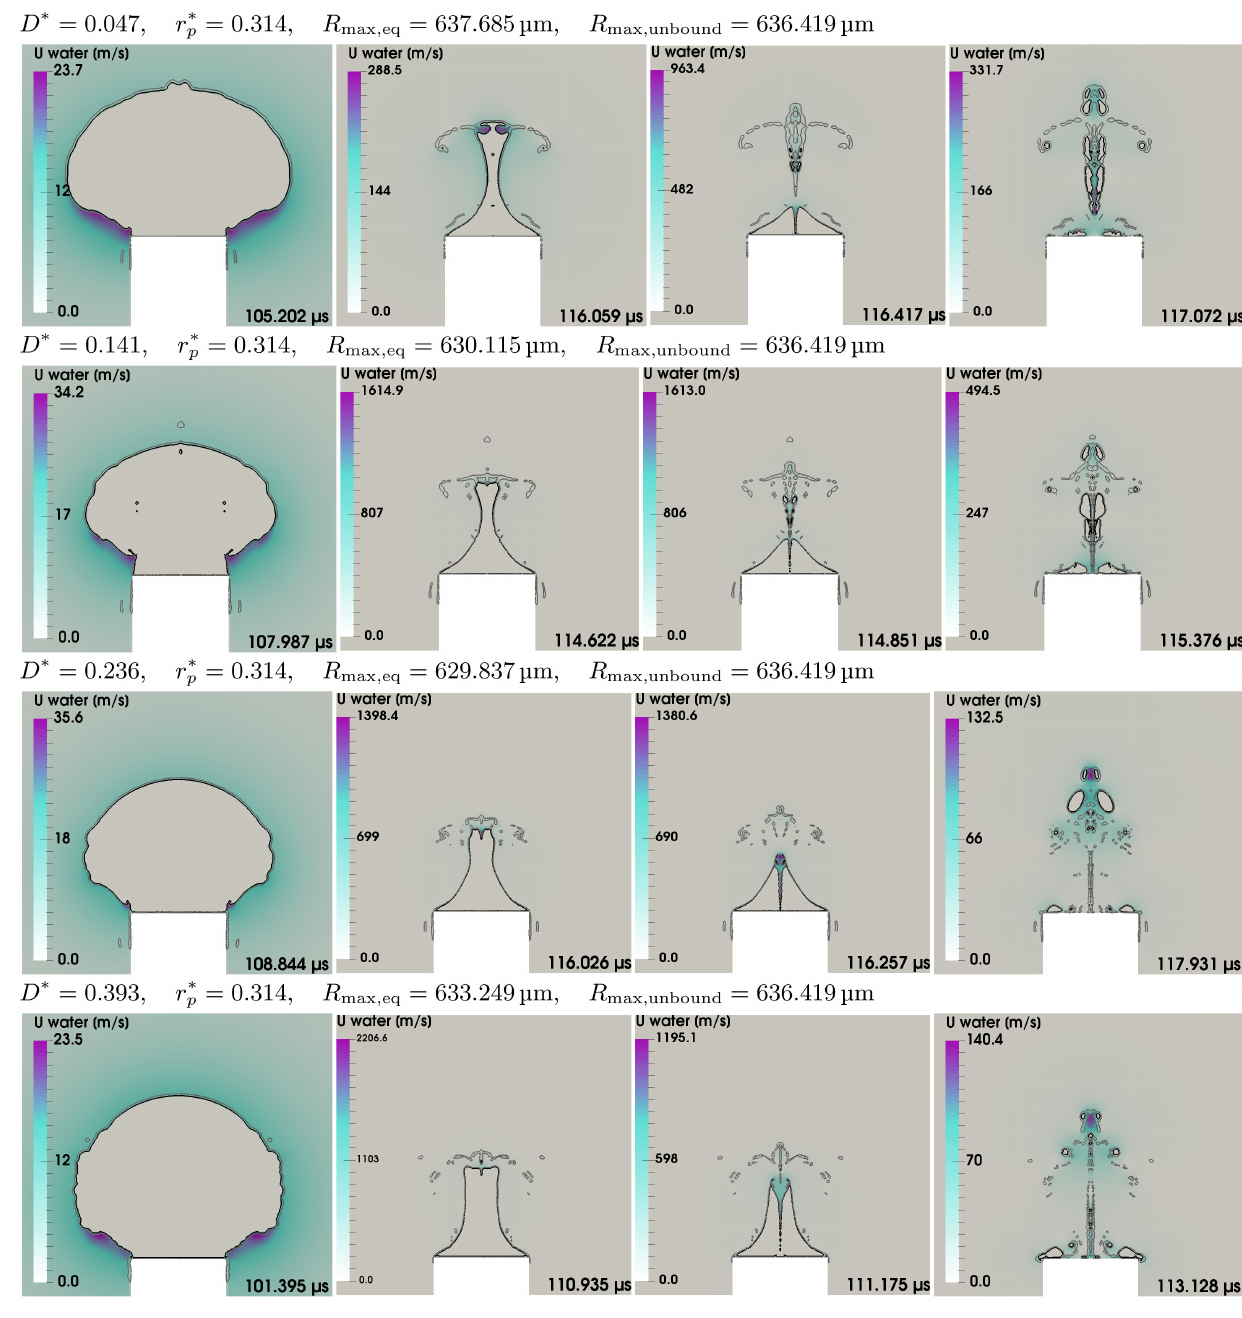
Figure A2. Mushroom bubble at r ∗ p = 0.314 for four different normalized distances D ∗ with the same R max,unbound . Cylinder radius is 200µm. Large overlap at maximum bubble volume over the pillar rim. At large overlap and small D ∗ , the mushroom stem gets long and slim (see the experiments). Note the stack of (torus) bubbles that is shot upwards away from the pillar (last